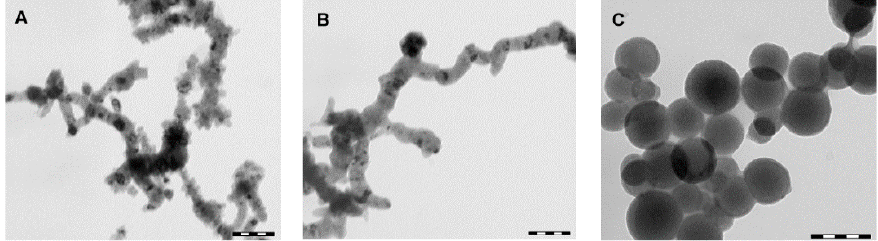
Figure 2. TEM micrographs: ( A ) iron oxide (IO) microparticles; ( B ) surface-modified iron oxide (ZV) microparticles; ( C ) core–shell microparticles (core–shell). Scale bar is 1 µm.